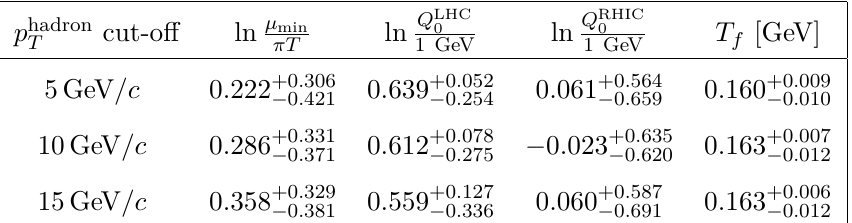
Table 3 . The table lists the medians and 95% credible limits of model parameters obtained for different choices of p hadron cut-off on experimental data. T